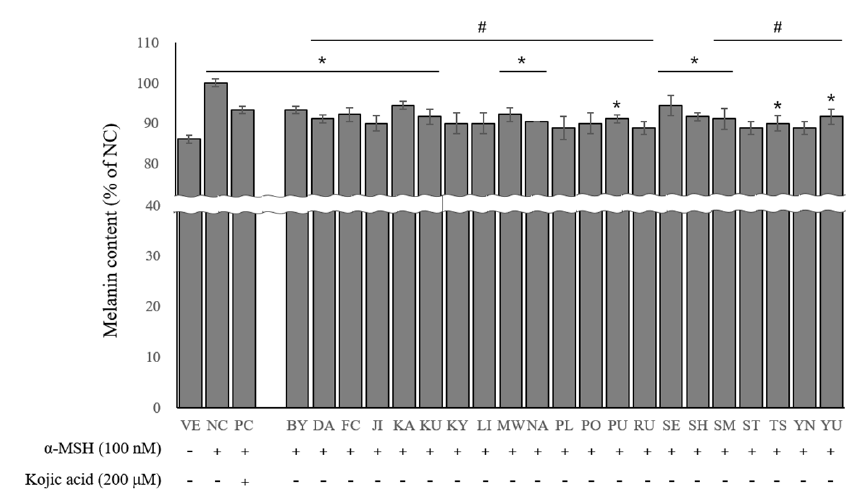
Figure 4. Effects of essential oils on melanin content. Values are presented as means ± standard deviations. Note: * p < 0.05 compared to VE; # p < 0.05 compared to NC. VE, vehicle group; NC, 100 nM α -MSH; PC, 200 µ M kojic acid; BY, C. platymamma ; DA, C. maxima ; FC, C. medica ; JI, C. sunki ; KA, C. X aurantium ; KU, C. japonica ; KY, C. unshiu X C. sinensis ; LI, C. limon ; MW, C. reticulata ; NA, C. X